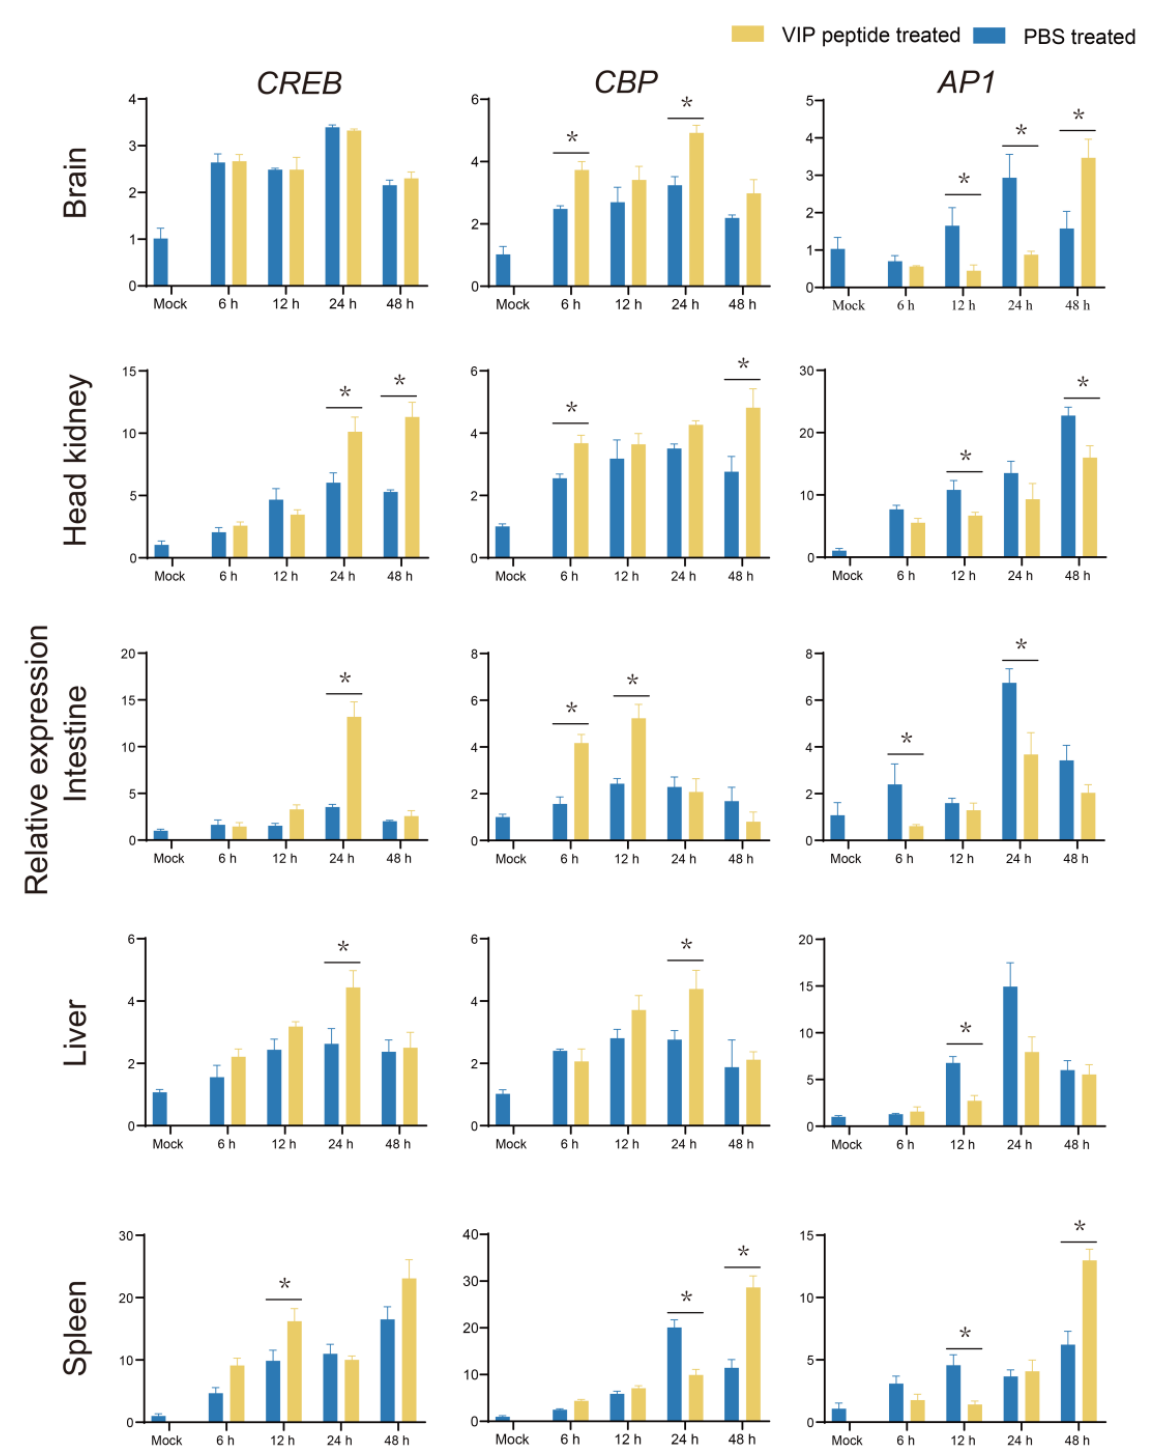
Figure 10. The expression profiles of cAMP-PKA pathway-related factors ( CREB , CBP , and AP1 ) at various points after S. agalactiae infection via qRT-PCR. Every value is presented as the mean and standard deviation; n = 3. The asterisks reveal the significant difference ( p < 0.05).